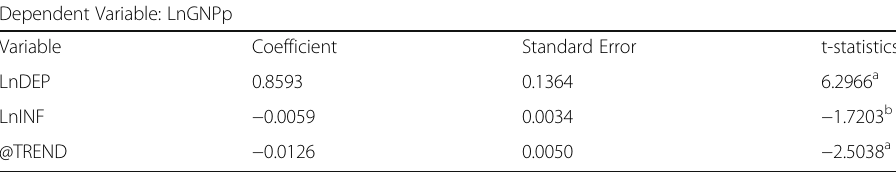
Table 6 ARDL Long-run